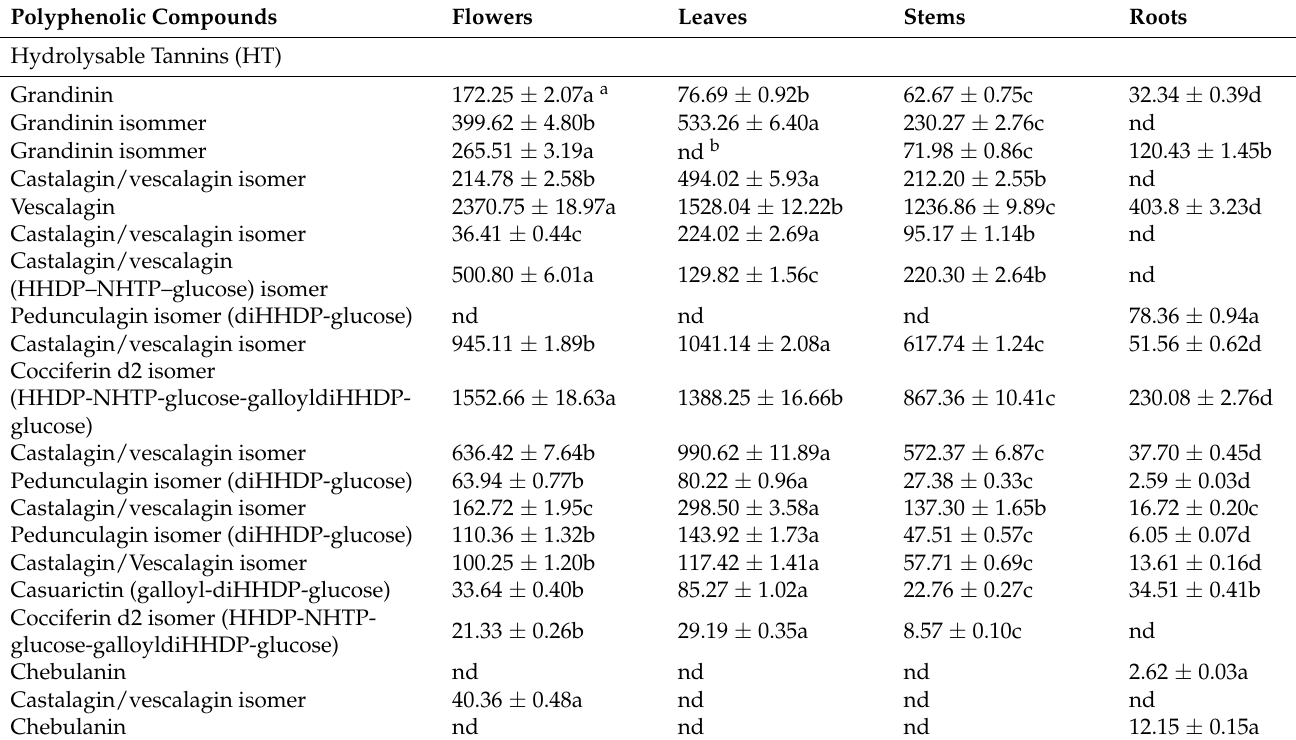
Table 2. Total polyphenol content in different parts of Stachys palustris L. [mg/100 g